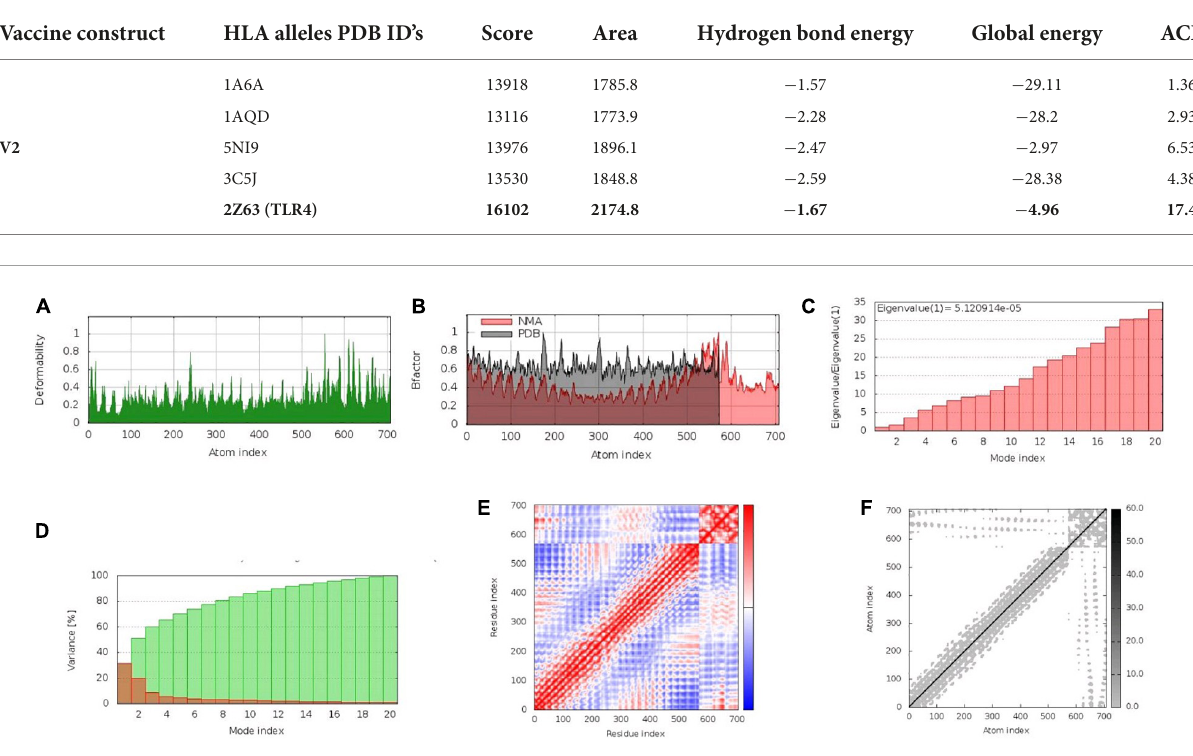
FIGURE4 Molecular dynamics simulation of vaccine construct (V2)–TLR4 complex. The stability of the protein-protein complex was examined by (A) deformability, (B) B-factor values, (C) eigenvalue, (D) variance, (E) covariance of residue index, (F) elastic network analysis.